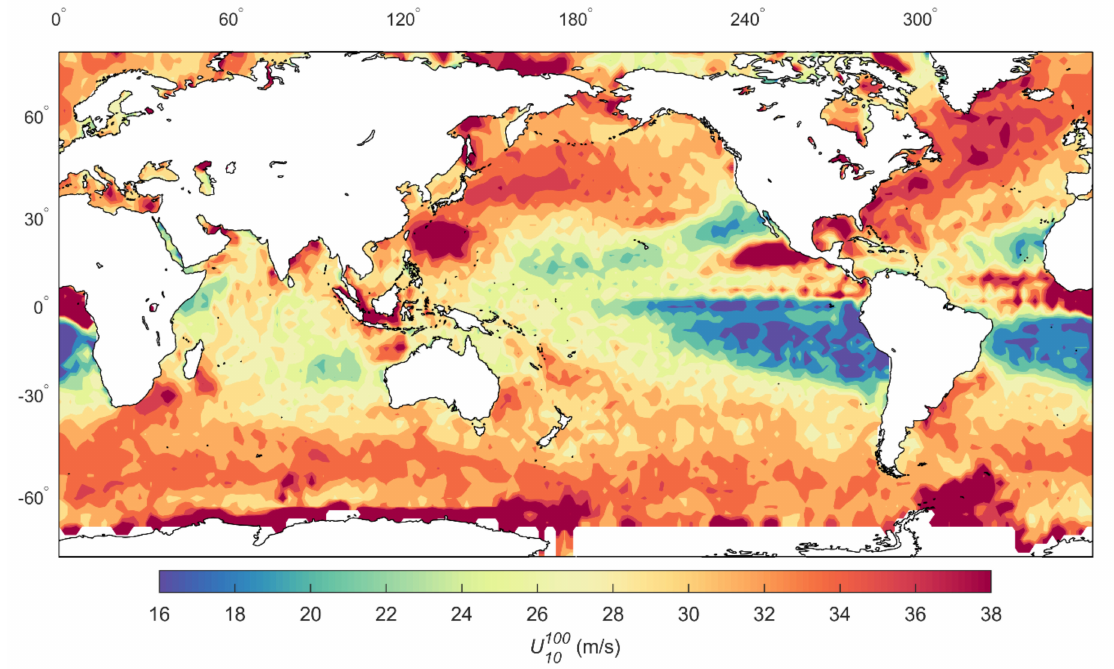
Figure 4. The 100-year return period wind speed, U 100 distribution. Data gridded at 2 ◦